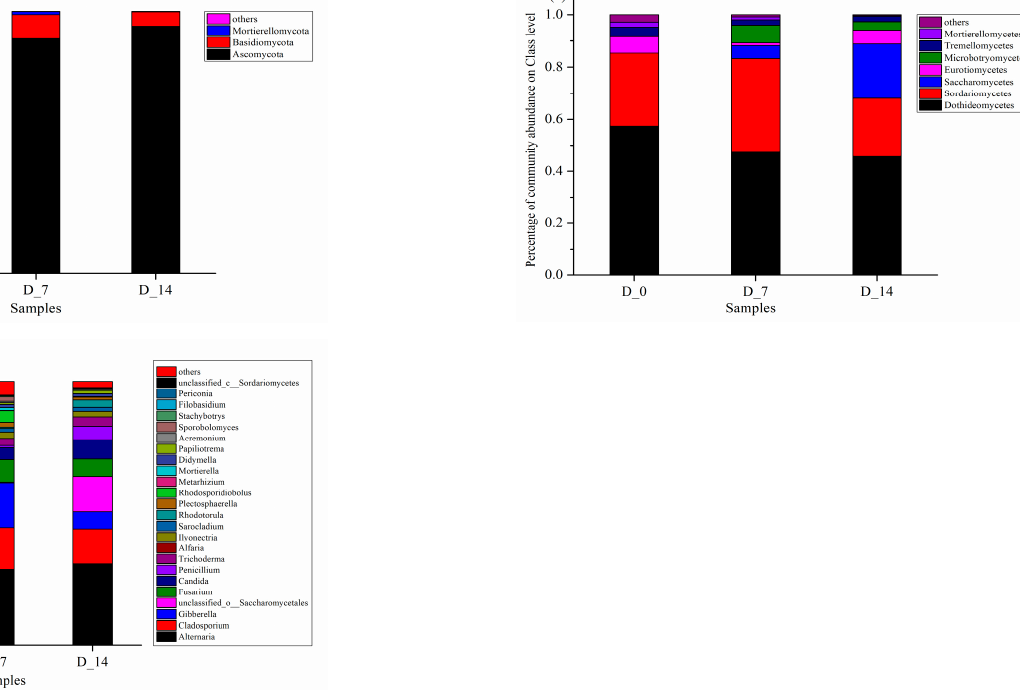
Figure 6. Community composition of fungi at phylum level ( a ), class level ( b ), and genus level ( c ).